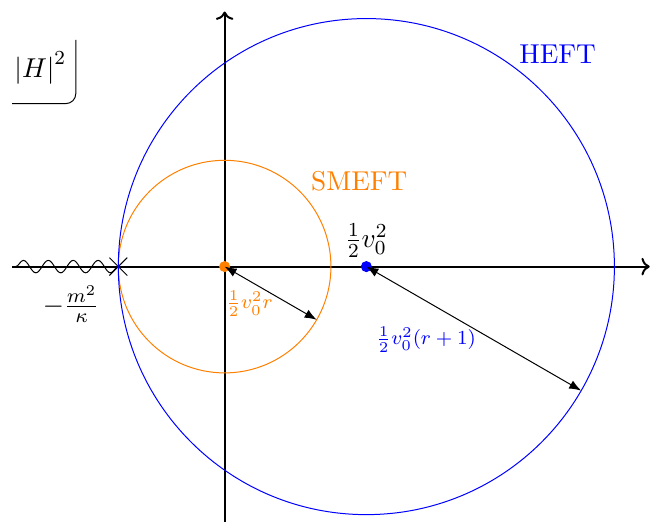
Figure 5 . Radii of convergence of the SMEFT (orange) and HEFT (blue) expansions in the complex plane of | H | 2 as a function of r = m 2 / ( κv 2 | H | 2 = − m 2 /κ